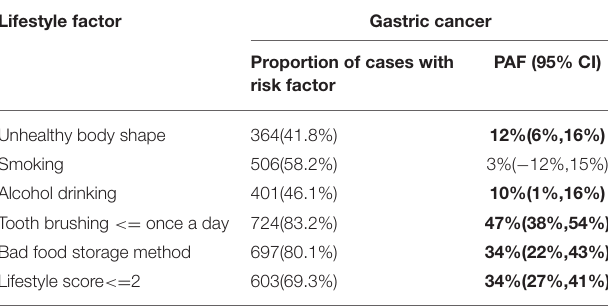
TABLE 3 | PAFs according to individual and combined lifestyle factors and the risk of gastric